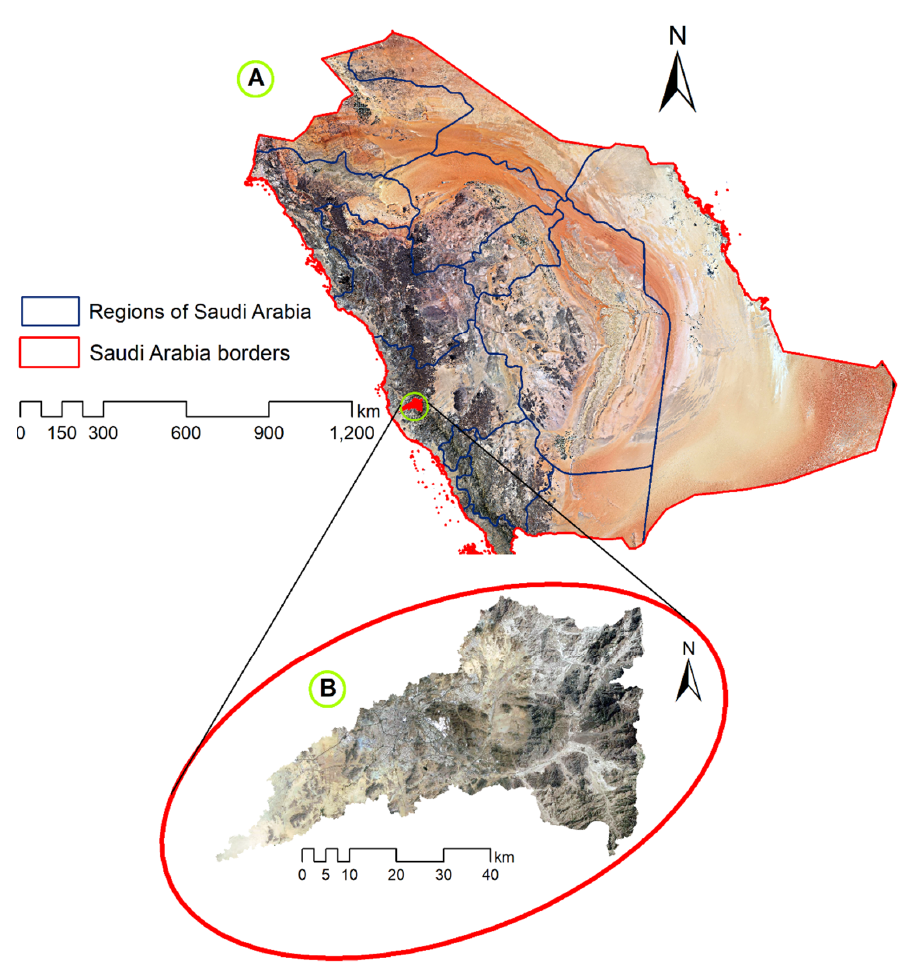
Figure 1. ( A ) Location map of Wadi-Uranah basin in Saudi Arabia, ( B ) a magnified view of the study site.